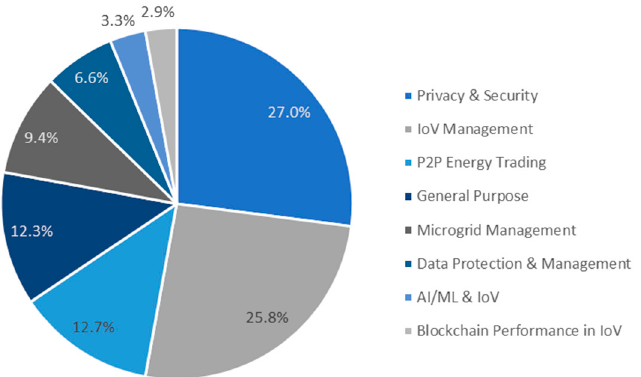
Figure 7. Blockchain applications in the IoV—classification according to their application areas. Table 3. Association of blockchain in different IoV application areas: